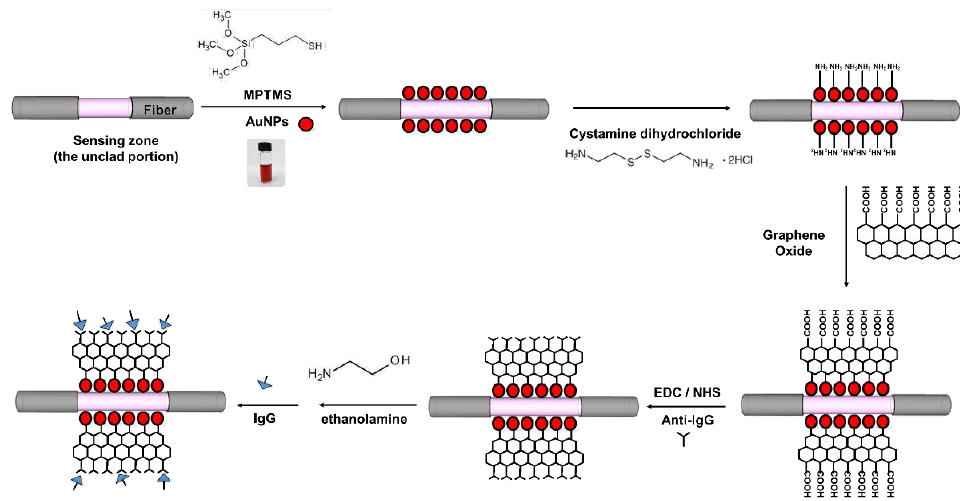
Figure 1. Schematic of the steps involved in the fabrication of sensor fiber .